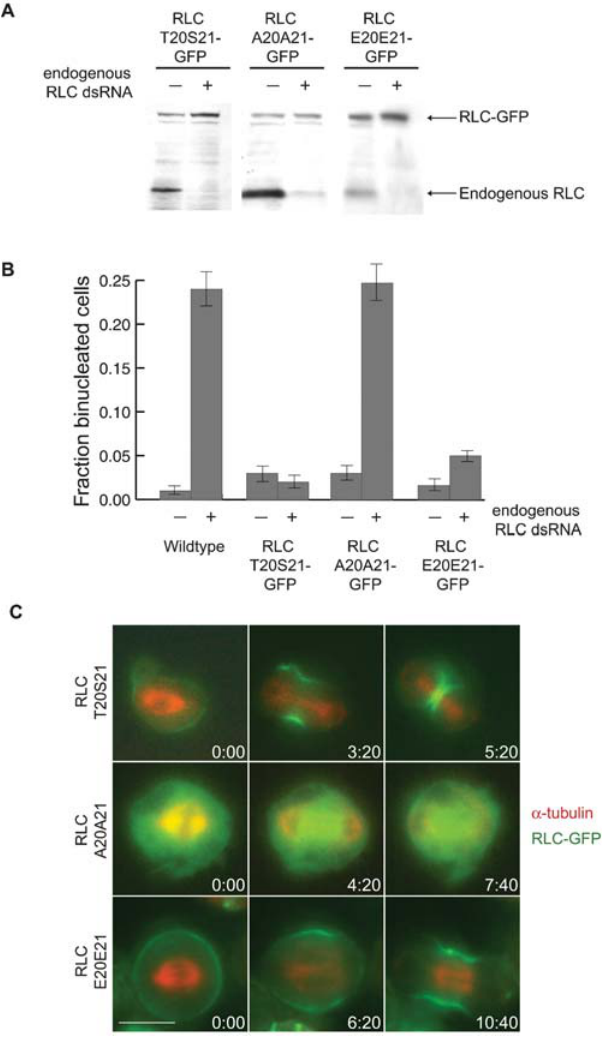
Figure 2. Phosphorylation of the RLC is necessary for cytokinesis and myosin II recruitment to the cleavage furrow. (A) Expression of mutant RLC constructs with alternative codons allows for depletion of only the endogenous RLC by RNAi. Cells expressing RLC-GFP constructs were treated with dsRNA that targets the endogenous sequence for 5 days. Proteins in the cell lysates of treated and untreated cells were separated by SDS-PAGE and immunoblotting with an anti-RLC antibody revealed that the lower molecular weight endogenous RLC is specifically depleted while the higher molecular weight GFP chimera is still expressed. (B) Phosphorylation of the RLC is essential for cytokinesis. S2 cells were treated with dsRNAs for 5 days to deplete the endogenous RLC and the fraction of approximately 100 cells that were binucleated (mean 6 SE) as measured by DAPI staining was calculated. The bar graphs show fraction of binucleate cells with and without treatment with RNAi against native RLC for wild type cells, cells expressing wildtype RLCT20S21-GFP, non-phosphorylatable RLCA20A21-GFP, and phospho-mimic RLCE20E21-GFP. (C) Phosphory- lation of the RLC is essential for myosin II recruitment to the cleavage furrow. S2 cells expressing RLC-GFP chimeras (green) and RFP- a -tubulin (red) were depleted of the endogenous RLC by RNAi treatment for five days, and timelapse fluorescence microscopy was used to film cells as they attempted to divide. Both RLCT20S21-GFP (Row 1) and RLCE20E21- GFP (Row 3) were recruited to the equatorial cortex during mitosis and the cells contracted. However, RLCA20A21-GFP (Row 2) was not recruited to the equatorial cortex at anaphase and the cells did not contract. The scale bar=5 m